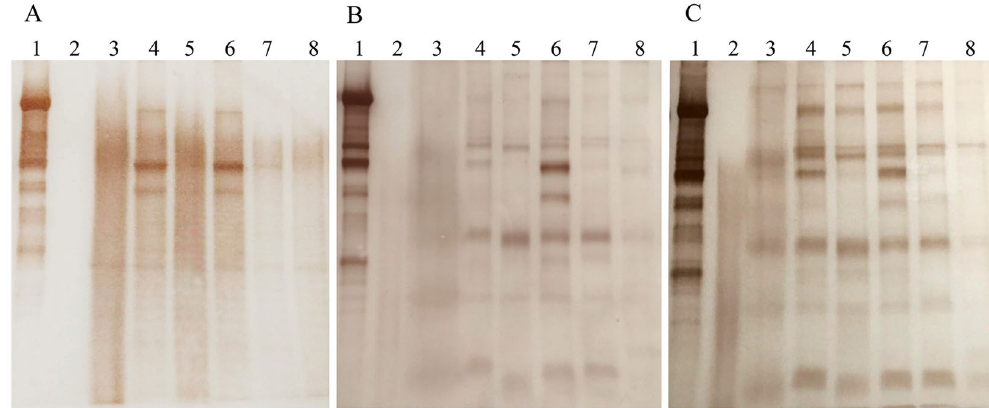
Figure 8. Western blot analysis of Vtg induction in different tissues of adult male guppy exposed to 50 ( A ), 100 ( B ), and 200 ng/L E 2 ( C ) for 21 days. Lane 1, WBH of ovariectomized female fish; lane 2, WBH of control male fish; lane 3, skin; lane 4, caudal fin; lane 5, gonad; lane 6, liver; lane 7, eye; lane 8, brain.